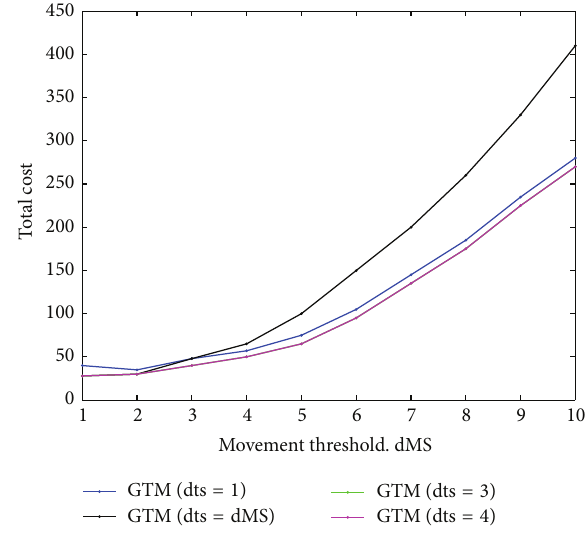
Figure 4: Total cost for various CMR values. Table 1: Parameter settings for the DHK